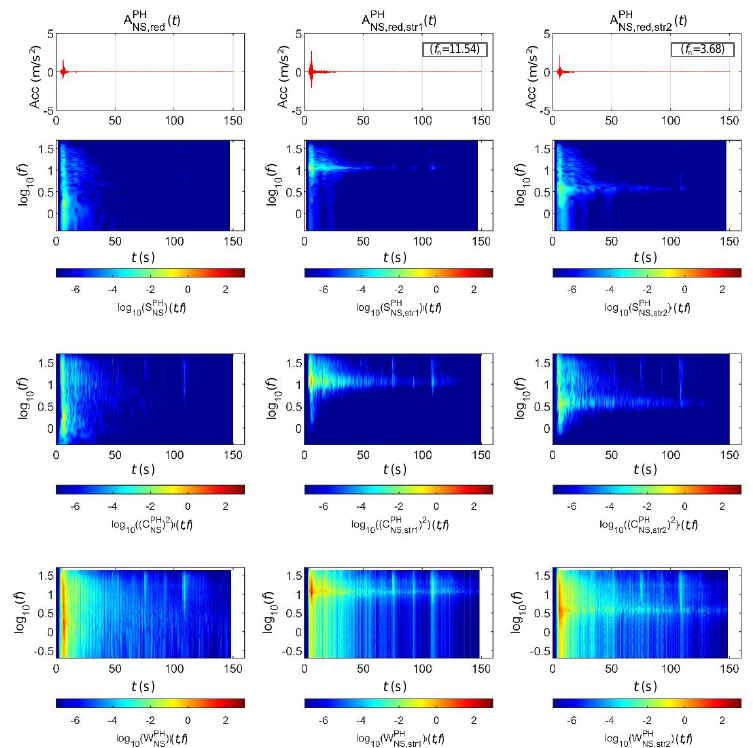
Figure 15. Analysis results of the Pohang earthquake data (scaled for 1000-year return period) and associated bridge response.